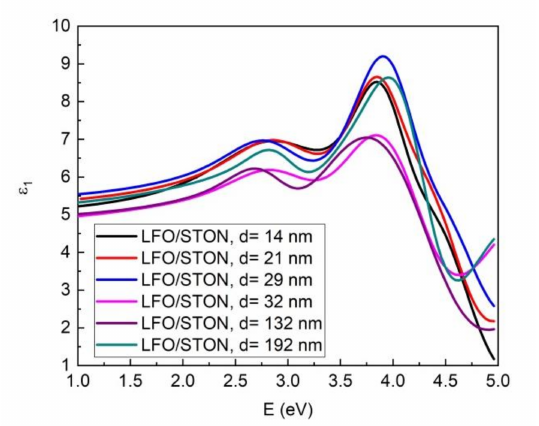
Figure 12. The dispersion of the real part of dielectric function ε 1 for LFO/STON thin films.